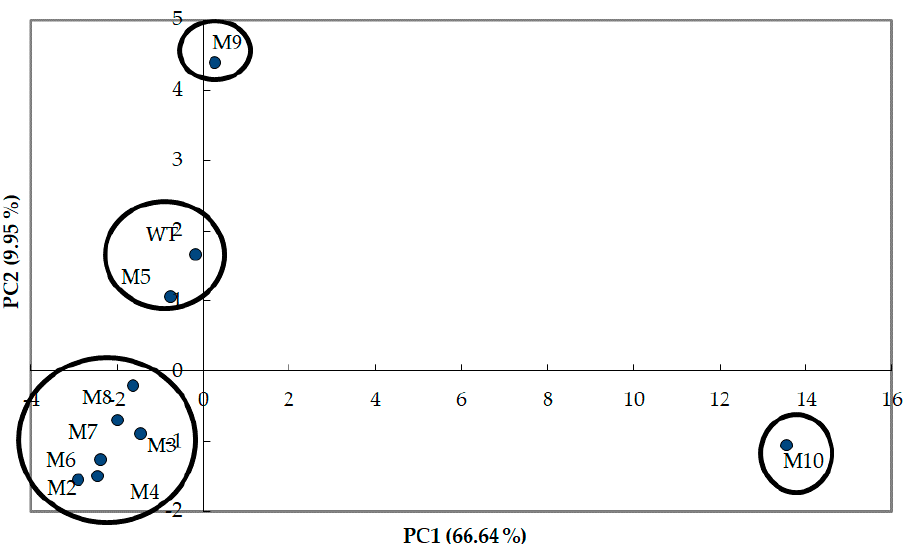
Figure 4. Score plot of PC2 vs PC1 according to the VOCs produced by the wild type and the UV-generated mutants of S. suaveolens. PCA was carried out using the Pearson’s method using the mean data of VOCs obtained for each strain. The Cattel’s scree diagram based on the eigenvalues, the cumulative variability, the correlations data between the VOCs and the principle components and the different VOCs contribution to PC 1 and PC 2 axis are provided in Figures S1 and S2 and Table S1 respectively. Table 2. Classification and quantification of VOCs according to pathway production in the wild-type of S. suaveolens and its 9 ILV- mutants.